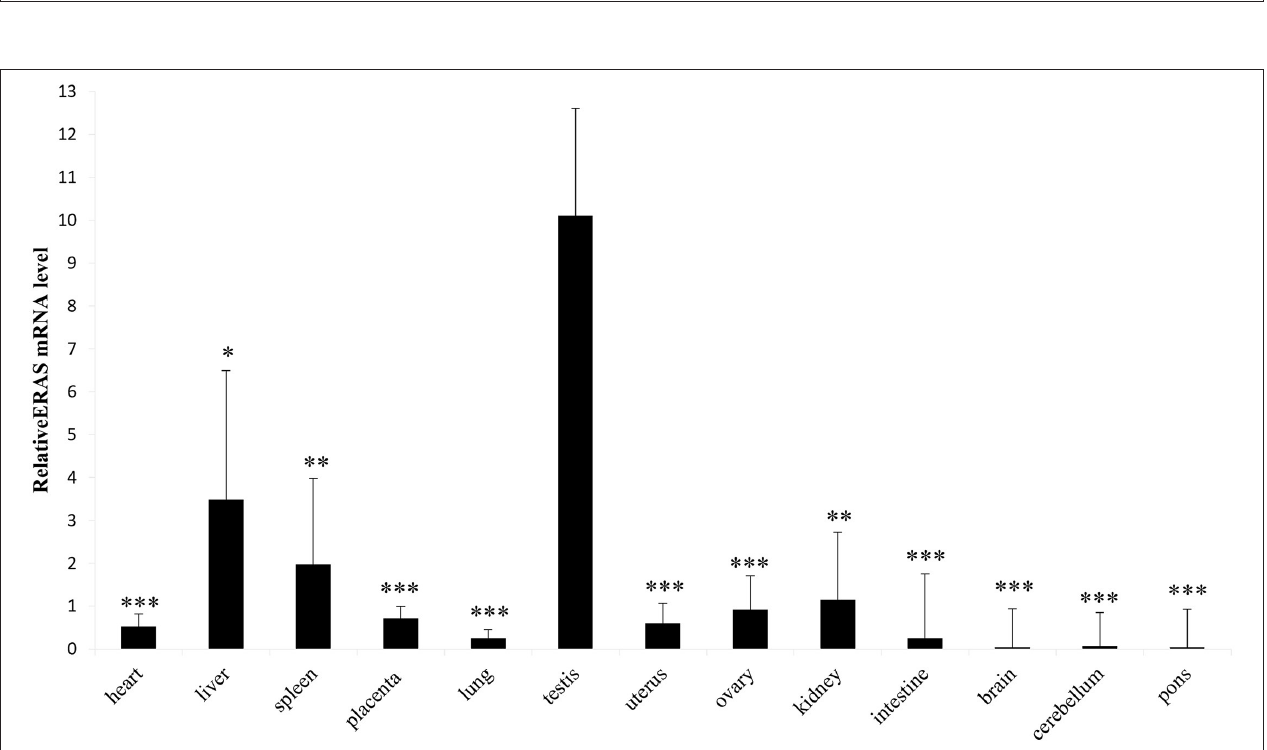
FIGURE 2 | Representative RT-qPCR shows equine tissues ERAS mRNA levels. Data are expressed as mean and standard error mean (S.E.M) of three separate experiments from several animals, each performed in triplicate, related to ERAS levels in the testis (* p < 0.05; ** p < 0.01; *** p < 0.001).